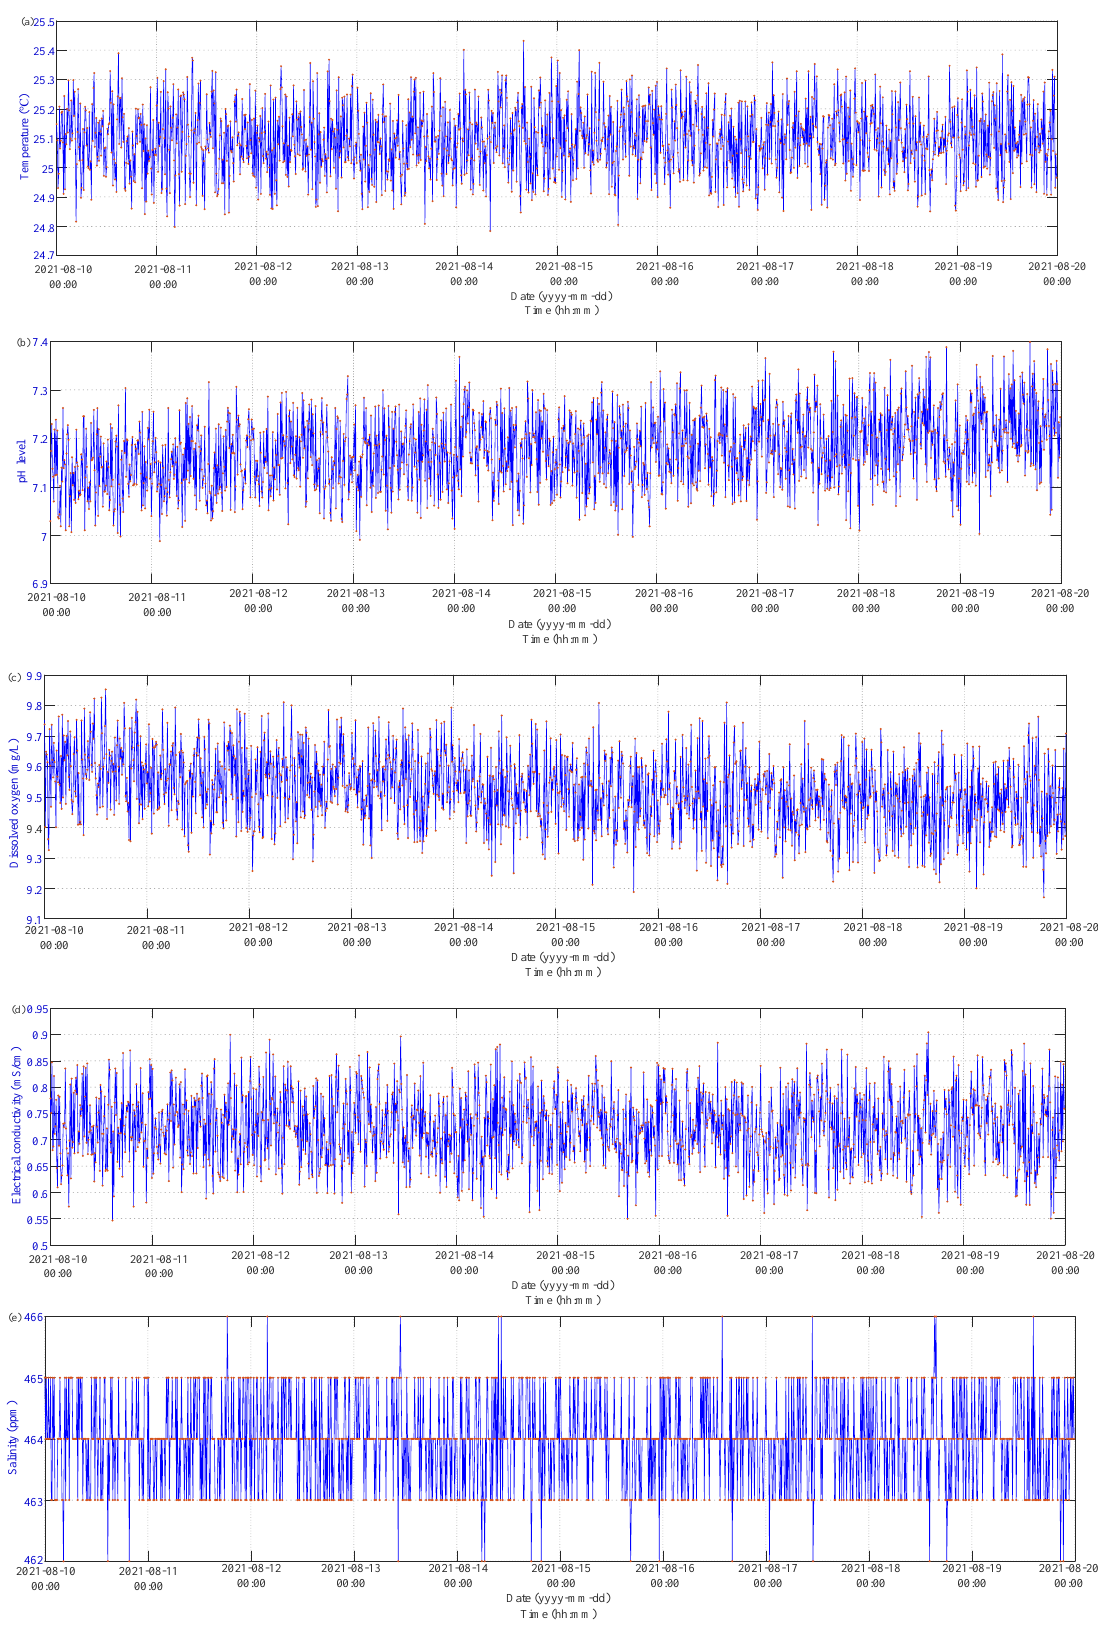
Figure 8. The 10-day in situ measurement results: ( a ) water temperature; ( b ) pH level; ( c ) DO level; ( d ) EC level; and ( e ) salinity level.